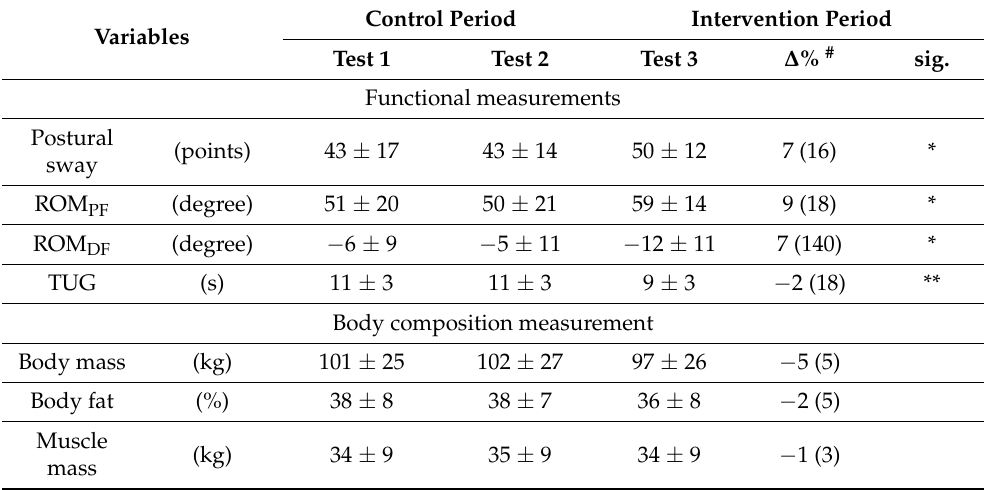
Table 1. Cont. Variables